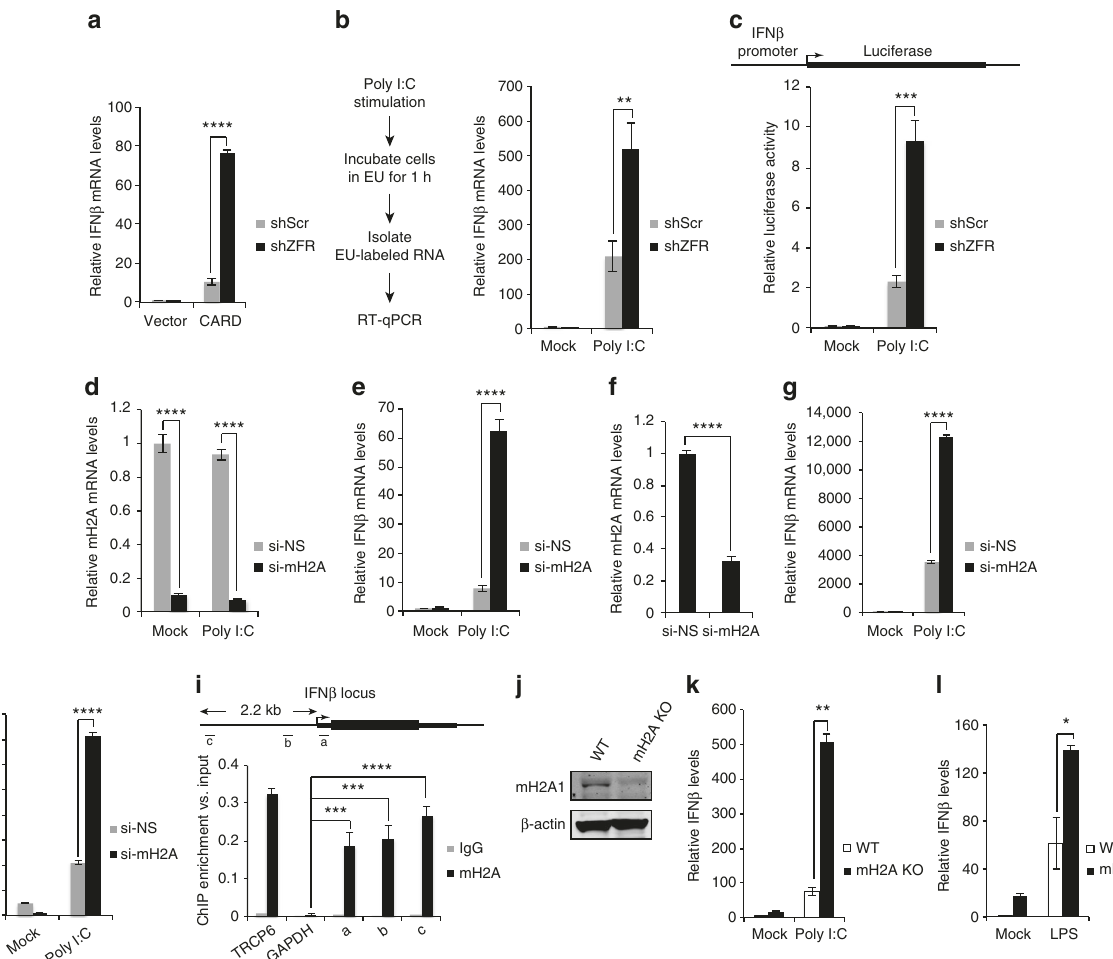
Fig. 6 mH2A1 is responsible for ZFR-mediated IFN β repression. a qRT-PCR analysis of IFNB1 after transient transfection of a plasmid DNA-expressing 3xFLAG-tagged RIG-I CARD domain in HEK-293TO cells stably transduced with shZFR or shScr ( n = 3). b Schematic of experiment to analyze synthesis of IFNB mRNA after poly(I:C) stimulation (left). qRT-PCR of newly synthesized IFNB1 mRNA 24h after poly(I:C) stimulation (right; n = 3). c Dual luciferase assay of cells transfected with plasmids expressing fi re fl y luciferase under the control of the IFNB1 promoter, with and without poly(I:C) stimulation ( n = 3). A plasmid constitutively expressing Renilla luciferase was used as control. d qRT-PCR analysis of mH2A1 in HEK-293TO cells transfected with si-mH2A1 or si-NS with and without stimulation with poly(I:C) ( n = 3). e qRT-PCR analysis of IFNB1 as in D ( n = 3). f qRT-PCR analysis of mH2A1 in mouse BMDMs transfected with si-mH2A1 or si-NS ( n = 3). g qRT-PCR analysis of Ifnb1 in BMDMs transfected with the indicated siRNAs and stimulated with poly(I:C) ( n = 3). h qRT-PCR analysis of I fi t1 as in g ( n = 3). i Chromatin immunoprecipitation-qPCR (ChIP-qPCR) analysis of mH2A1 binding to the IFNB1 promoter region in HEK-293TO cells. Isotype-matched IgG was used as a control. Fold enrichment over input is shown for each location ( n = 3). j Immunoblot analysis of mH2A1 in BMDMs from WT or macroH2A double knockout mouse. Approximate MW based on size markers is shown. k qRT-PCR analysis of Ifnb1 in BMDMs stimulated with poly(I:C) or ( l ) LPS. Graphs indicate mean ±SD; * P < 0.05, ** P < 0.01, *** P < 0.001, **** P <0.0001 (two-tailed Student ’ s t